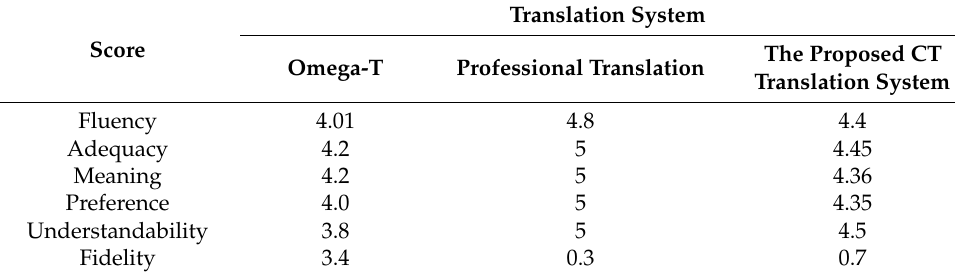
Table 2. Manual evaluation of the translation quality, for the English-French